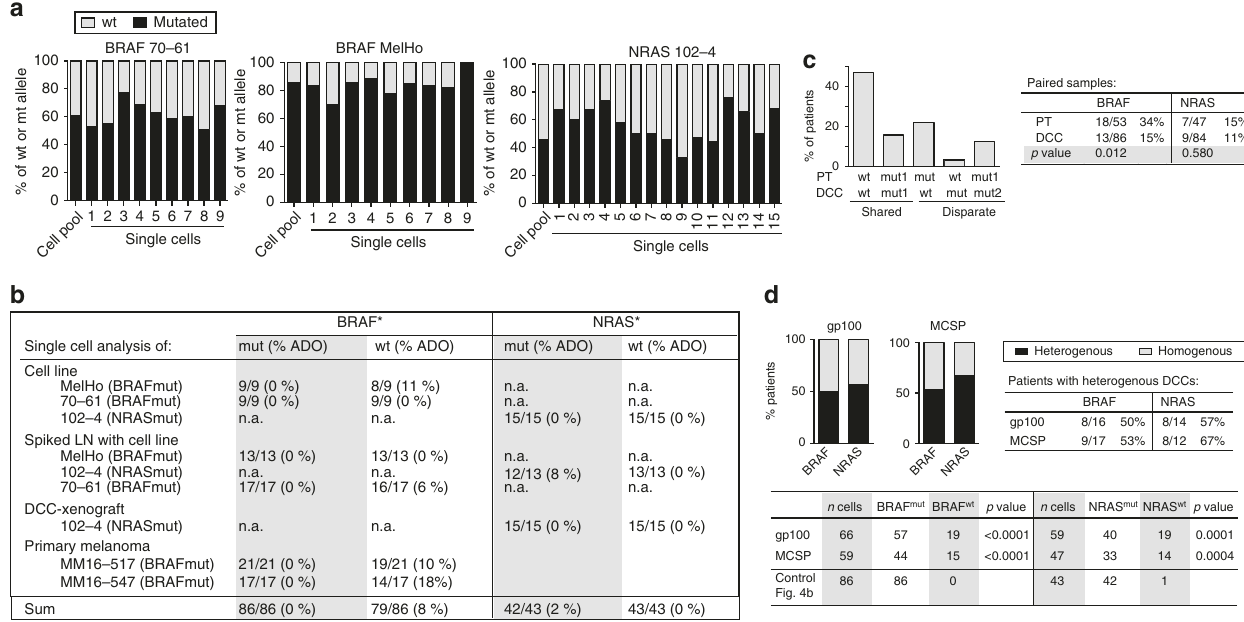
Fig. 4 BRAF and NRAS mutations in PTs and DCCs. a Single cell WGA reliably captures wild-type and mutated alleles. Exon 15 mutation c1799T > A ( BRAF ) and Exon 2 mutation c181C > A ( NRAS ) were detected in all single cells (lanes 1 – 9 or 1 – 15) of cell lines with BRAF (cell lines 70 – 61 ( n = 9) and MelHo ( n = 9)) or NRAS (cell line 102 – 4; n = 15) mutation. The allelic ratio of wt vs. mut alleles of each cell line was determined using pooled DNA. Note that this ratio is preserved in most single cells. b Summary of results in a and detection of BRAF and NRAS mutation in single gp100+ cells isolated from (i) lymph nodes from healthy controls spiked with melanoma cell line cells, processed and stained as SLN of melanoma patients; (ii) an enzymatically digested DCC- xenograft derived from NRAS-mutated DCCs and (iii) primary melanomas with BRAF mutation. c Mutation analysis of BRAF and NRAS for paired PT-DCC samples ( n = 32 patients). Different mutations (either NRAS or BRAF ) are indicated by mut1 and mut2. Fisher ’ s exact test p values indicate differences in BRAF mutational status between PTs and DCCs. d Percentage of patients ( n = see Table 1) with homogeneous (all cells harbouring the mutation) and heterogeneous BRAF / NRAS mutational status among DCCs. DCCs were detected using two markers, gp100 ( n = 43 cells) or MCSP ( n = 61